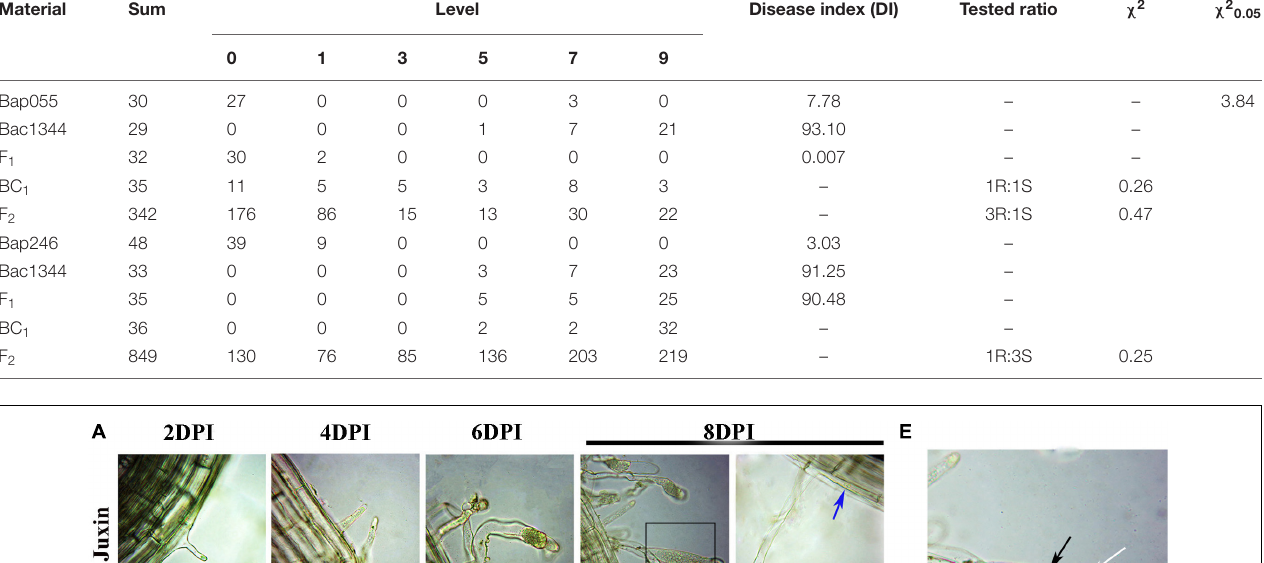
TABLE 2 | Genetic analysis of clubroot resistance in Bap055 and Bap246. Material